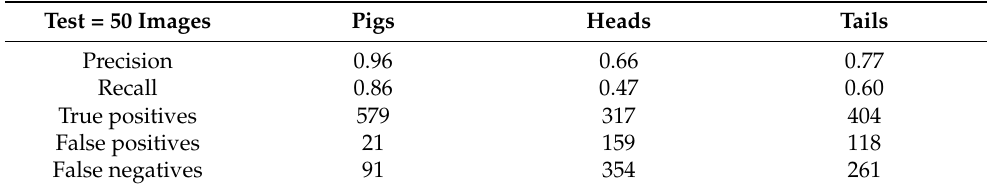
Figure 7. Visualization of the object detection of pigs, their heads and their tails by Mask R-CNN. Table 3. Detection precision and visualization of object detection of pigs, heads and tails by Mask